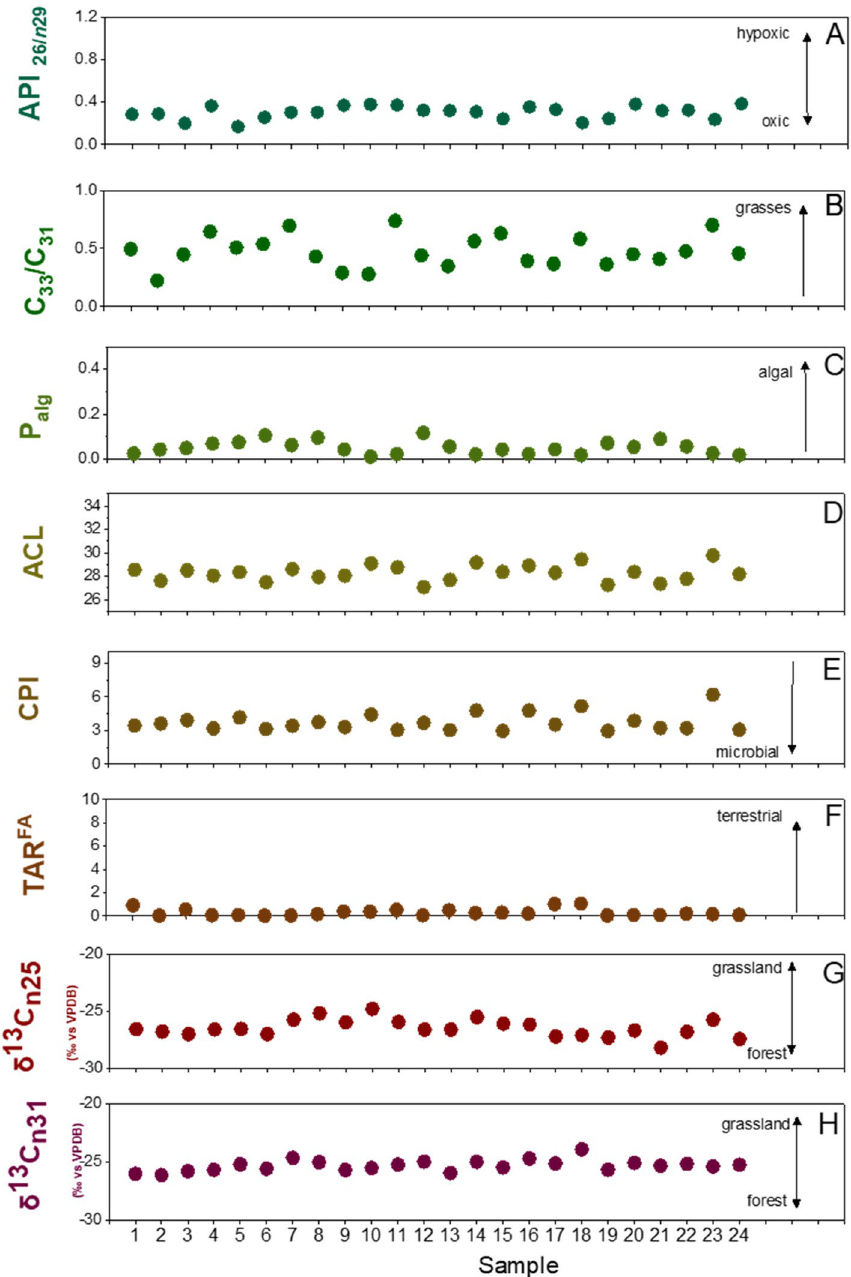
Figure 6. Key proxies measured for sediments excavated from at AGS. ( A ) API: alcohol preservation index uses only n-hexacosanol and n-nonacosane. Higher values indicate more hypoxic conditions 27,28 . ( B ) C 33 /C 31 : ratio of nC 33 to nC 31 . Higher values indicate more grasses 22,23 . ( C ) P alg : ratio of algal lipids (nC 17 + nC 19 ) relative to algal and terrestrial plant lipids (nC 17 + nC 19 + nC 29 + nC 31 ). Higher values indicate more algal input 20 . ( D ) ACL = average chain length of individual n-alkane abundances 20 . ( E ) CPI = [∑odd(C 21–33 ) + ∑odd(C 23–35 )]/ (2∑even C 22–34 ): carbon preference index, which is indicative of the abundance of odd over even carbon chain lengths. In general, lower CPIs indicate microbial inputs or maturation of the sample 20 . ( F ) TAR FA : terrigenous to aquatic n-alkanoic acids ratio reflecting the importance of terrigenous as compared to aquatic sources (C 24 + C 26 + C 28 )/(C 14 + C 16 + C 18 ). Higher values indicate more terrestrial input 35 . ( G , H ) Plant-lipid δ 13 C values for n-alkane C 25 and C 31 . Higher values indicate more C4 plant dominated environment 40